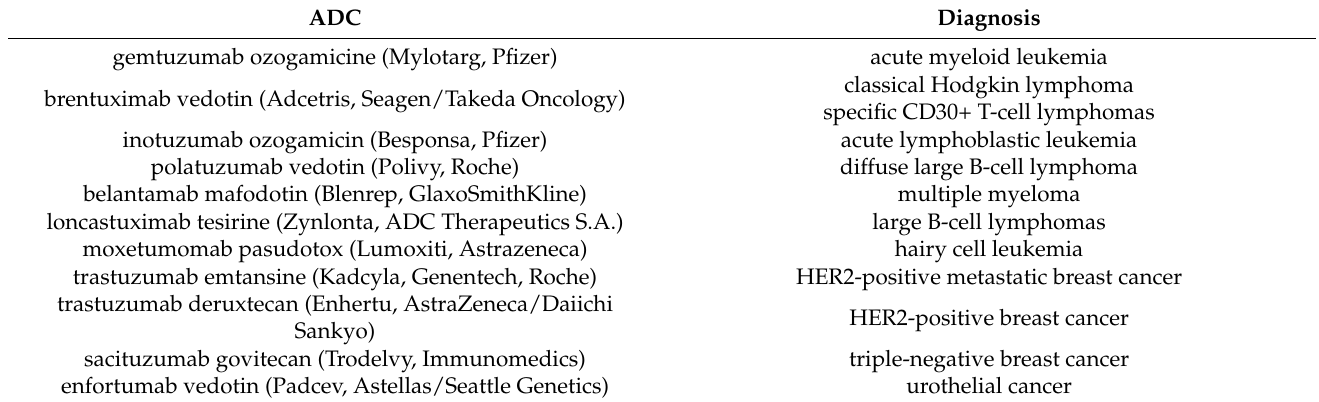
Table 1. Antibody-drug conjugates approved by FDA for hematooncological and oncological disorders.